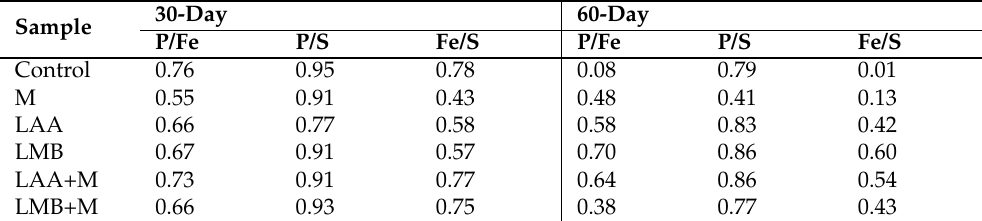
Table 2. Relationships between DGT-labile P, DGT-labile Fe, and DGT-labile S ( p < 0.05) in sediments of the six treatments used in the